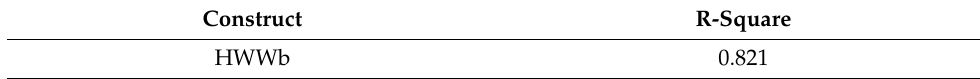
Table 10. R Square